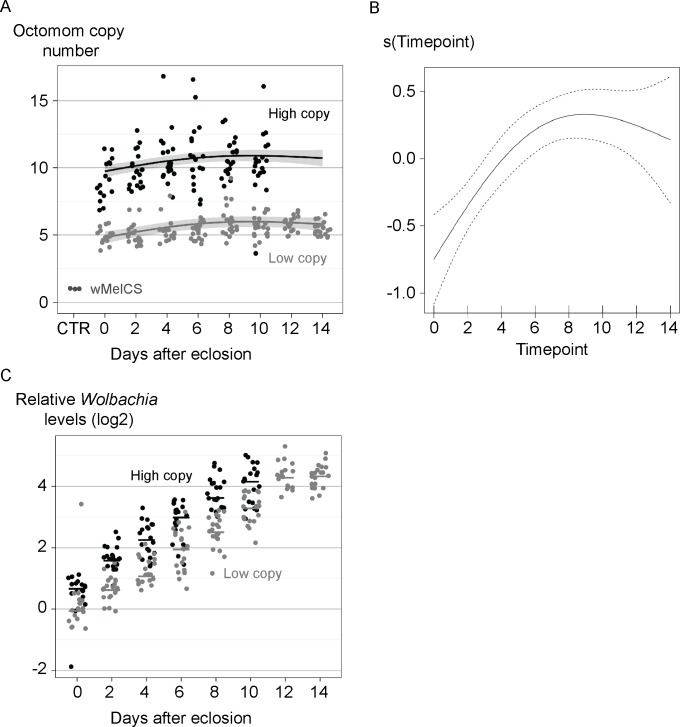
Octomom copy number and Wolbachia levels during adult D. melanogaster life.(A) Each dot represents WD0513 genomic levels in a single fly, as we have previously shown that this gene can be used to estimate Octomom region copy number [5]. The values were obtained using the Pfaffl method with wsp as a reference gene and calibrated using the median of three samples of control wMelCS_b flies (CTR). The lines represent the fit of the generalized additive model (GAM) and shaded area—the 95% confidence interval. (B) Fitted GAM smooth of Octomom copy number in response to the age of adults. The 95% confidence interval is indicated by the dashed lines. Note the Y-axis is standardized so that average is zero. (C) Each dot represents wsp levels in a single fly. Lines are medians of the replicates. wsp levels were obtained using Pfaffl method with Rpl32 as a reference gene and calibrated using the median of the low copy number samples at time zero. (A) and (C) represent data from single females derived from the 3rd generation of selection for Octomom copy number in the DrosDel isogenic w1118 genetic background [5]. Females were raised and kept at 25°C (survival of their siblings is shown in Fig S5A of [5]). Supporting data can be found in S1 Data.